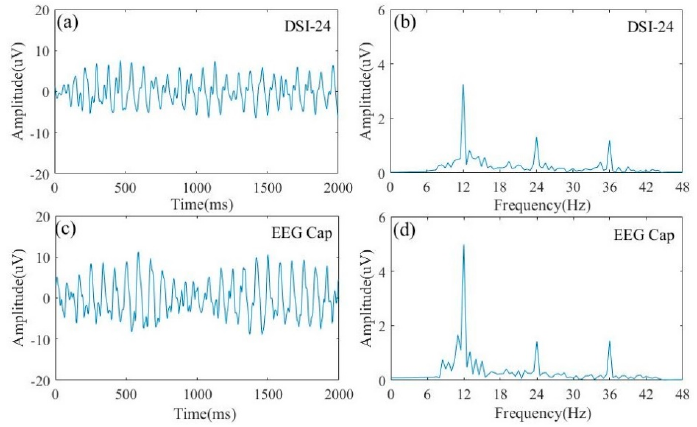
Figure 4. A typical stable visual evoked EEG waveform ( a ) and its spectrum ( b ) at 12 Hz recorded by the DSI-24. A typical stable visual evoked EEG waveform ( c ) and its spectrum ( d ) at 12 Hz recorded by the EEG cap.